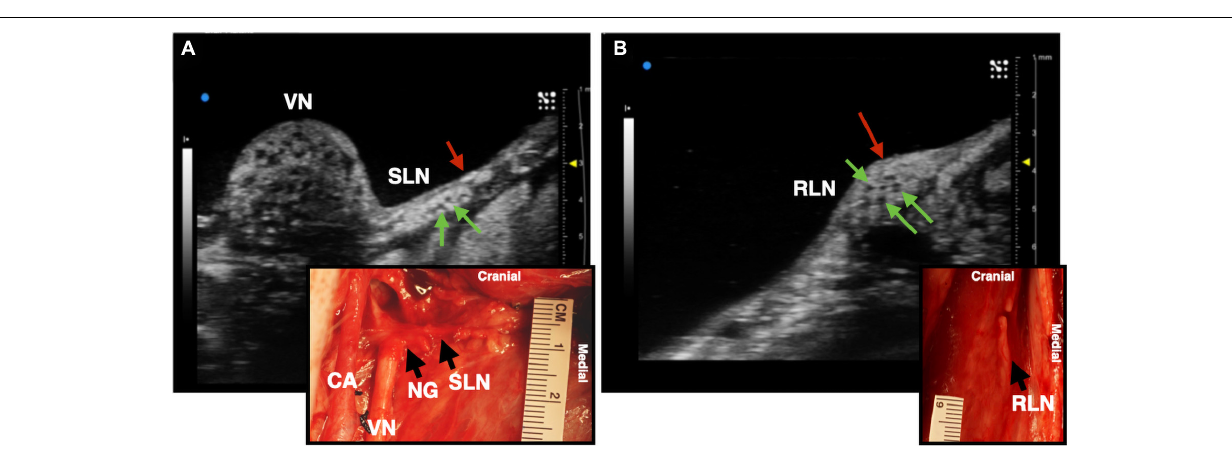
FIGURE 4 | Ultrasound images of the superior laryngeal nerve (SLN) and recurrent laryngeal nerve (RLN) branches of the vagus nerve (VN) in one live representative subject ( n = 1). (A) The SLN (red arrow) branching ventromedially off of the nodose ganglion (NG). Green arrows indicate fascicles within the nerve. (B) The RLN (red arrow), running along the esophageal groove. Green arrows indicate fascicles. Photograph insets in both (A,B) depict the corresponding ultrasound region within the surgical pocket; carotid artery